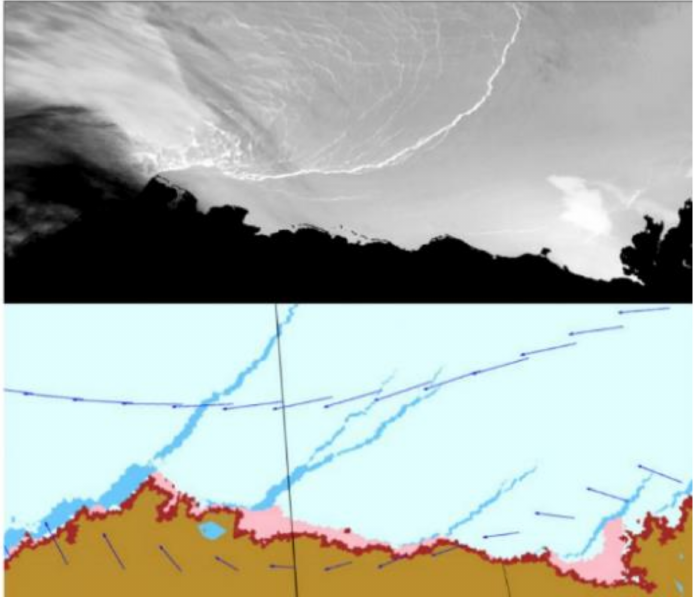
Figure 7. Observations and simulation comparison for 6 April 2001 lead formation (from